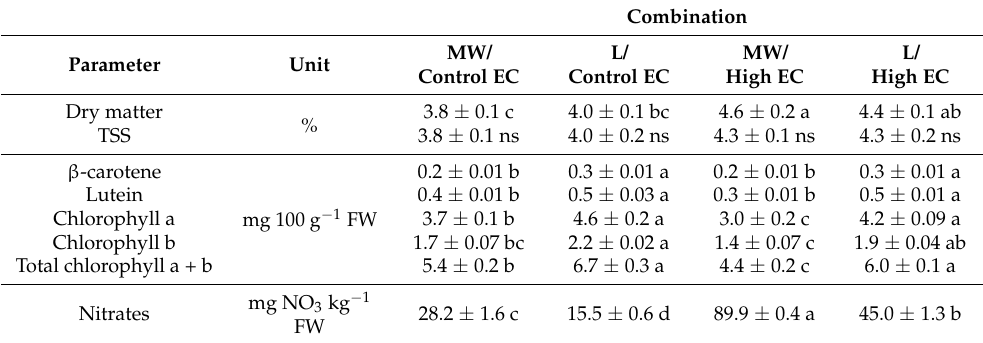
Table 5. Contents of dry matter, TSS and bioactive compounds in cucumber fruits (average from two